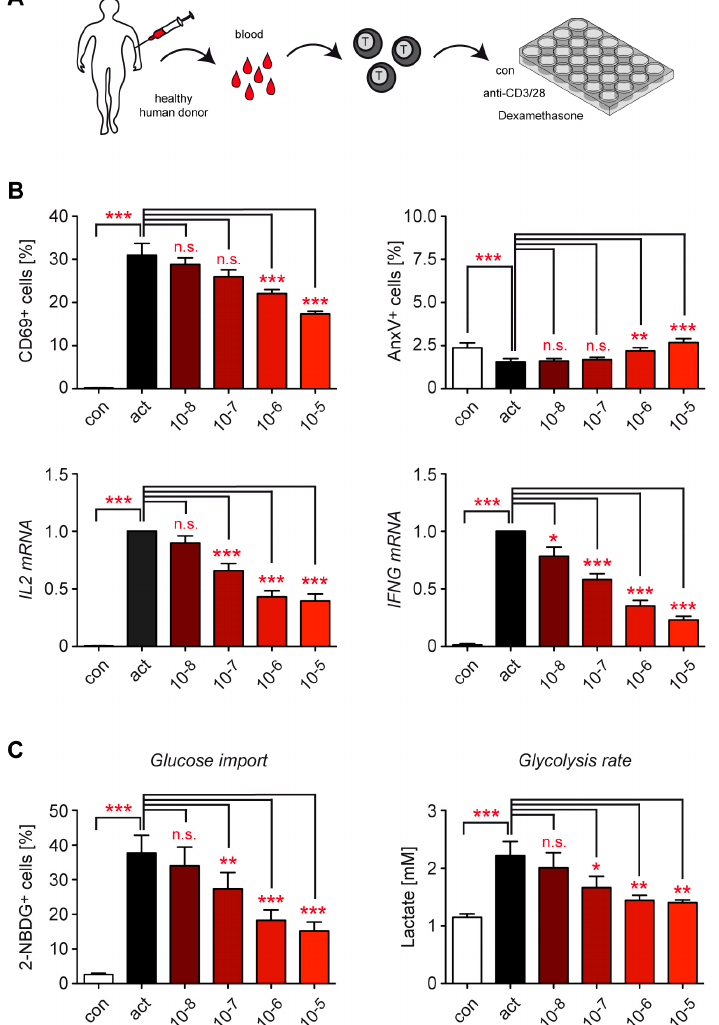
Figure 3. Repression of T cell functions and metabolic processes in human peripheral blood T cells by Dex in vitro. ( A ) Setup of the experimental model. ( B ) T cells were purified from buffy coats of healthy human donors and stimulated with hCD3 ε and hCD28 antibodies for 20 h in the absence (act) or presence of 10 − 8 to 10 − 5 M Dex. Unstimulated T cells served as a control (con). The percentages of CD69 + and AnxV + CD3 + CD4 + T cells were determined by flow cytometric analysis; N = 17/12. IL2 and IFNG gene expression was analyzed by RT-qPCR. N = 12. Relative mRNA levels were calculated by normalization to the housekeeping gene 18SRNA . Expression in activated T cells was arbitrarily set to 1. ( C ) T cells were purified and treated as described for panel B. Glucose import was determined by incubating the cells for 1 hr with fluorescently labeled 2-NBDG and measuring the percentage of CD3 + CD4 + T cells positively stained for 2-NBDG by flow cytometry (left panel, N = 15). The glycolysis rate was analyzed by measuring the absolute concentration of lactate in the cell culture supernatant with the help of a photometric assay (right panel, N = 4). All values are depicted as the mean ± SEM. Statistical analysis was performed by one-way ANOVA followed by a multiple comparisons test. Levels of significance: * p < 0.05; ** p < 0.01; *** p < 0.001; n.s.: p >